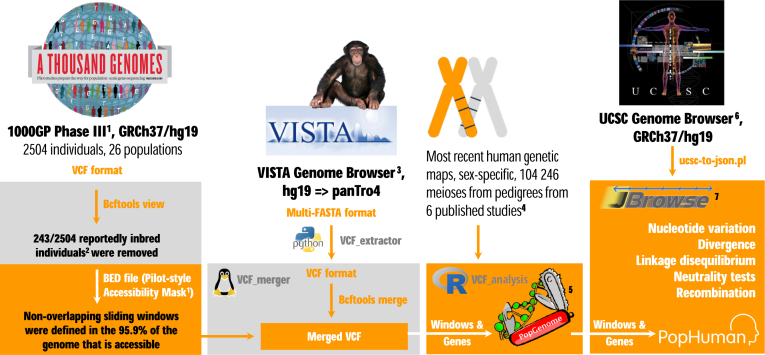
PopHuman pipeline. Cited references in the figure: 11000GP Phase III (15); 2Inbred individuals in the 1000GP (20); 3VISTA Genome Browser (23); 4Human genetic maps (24); 5PopGenome software (25); 6UCSC Genome Browser (35); 7JBrowse software (34).